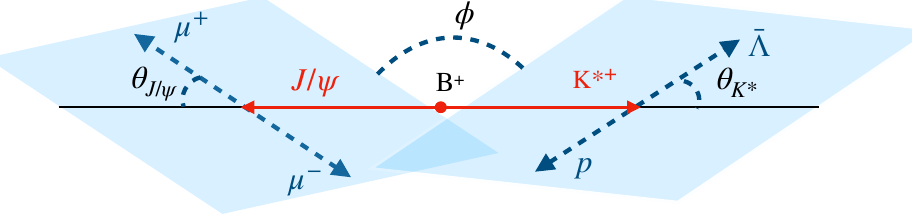
Figure 2 . An illustration of the decay angles in the B + ! J = K (cid:3) +